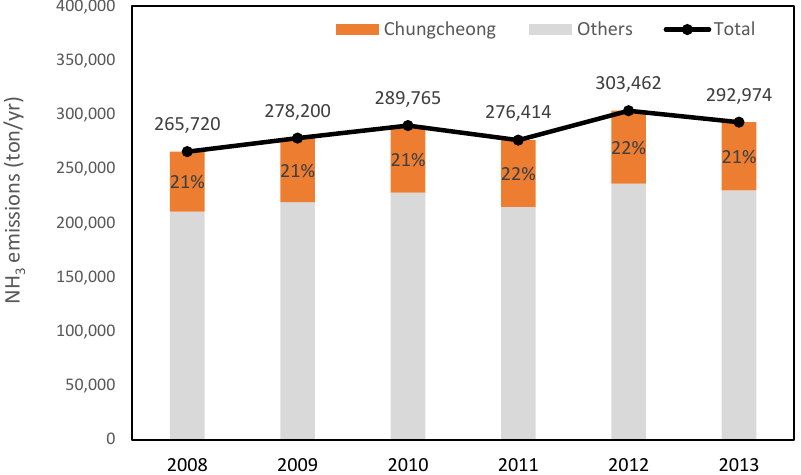
Figure 2. Trend of NH 3 emissions in South Korea (2008~2013).